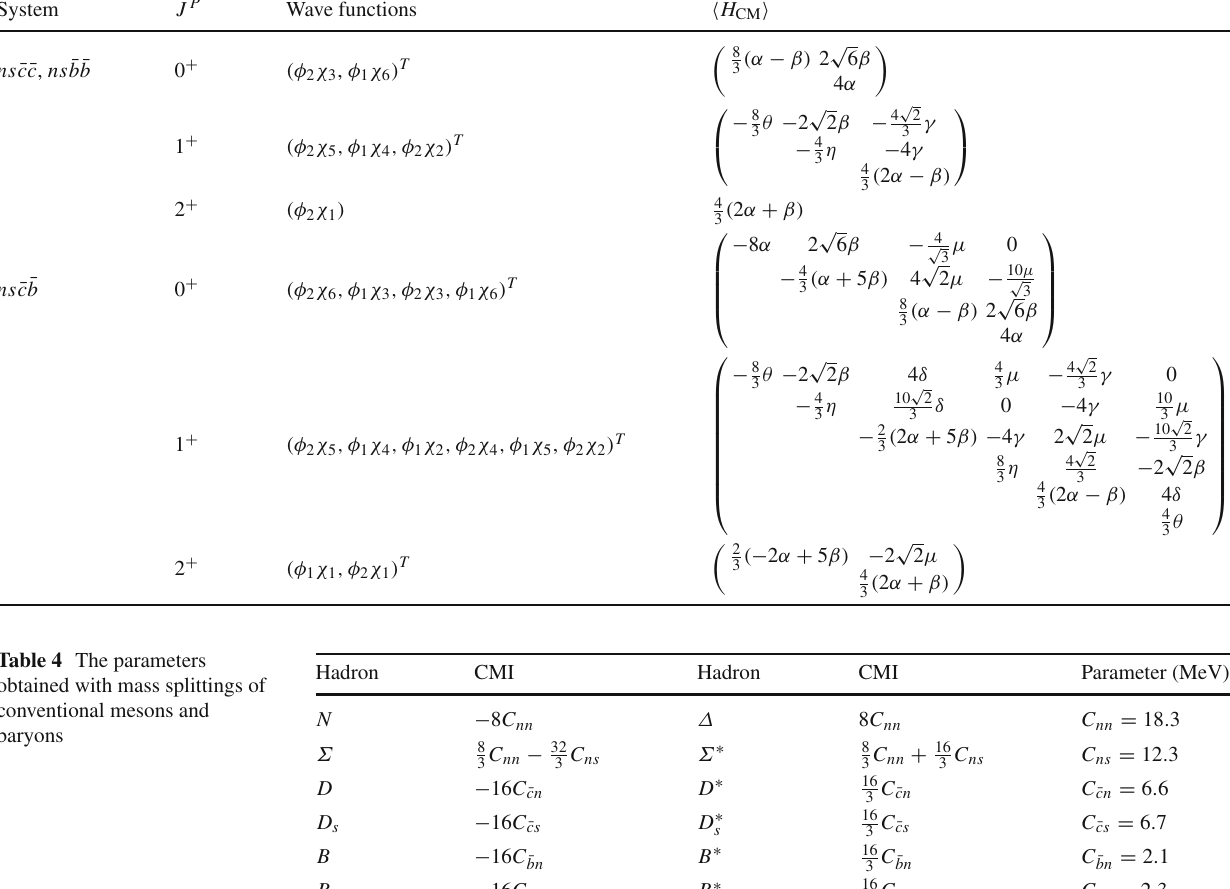
Table 3 The quantum numbers, color–spin wave functions, and the corresponding CMI matrices for the ns ¯ c ¯ c , ns ¯ b ¯ b , and ns ¯ c ¯ b systems System